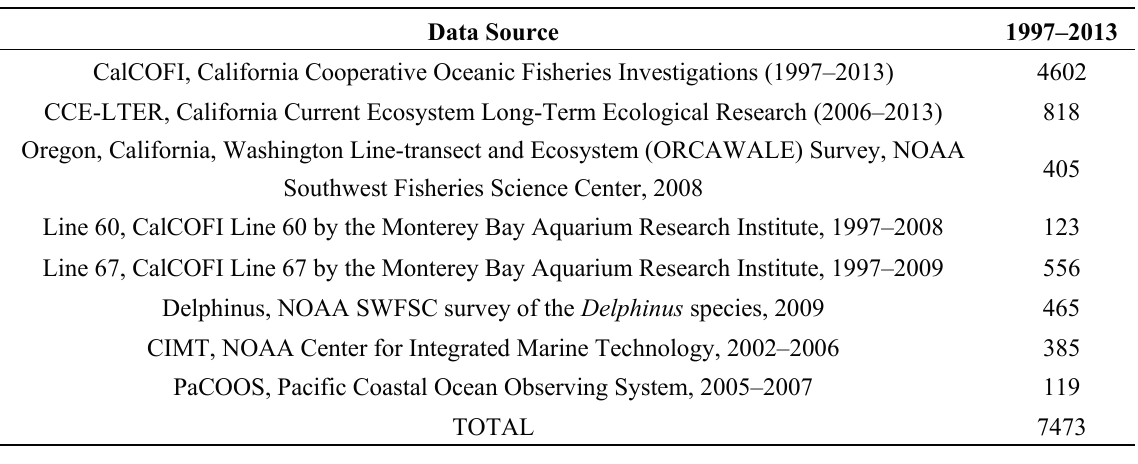
Table 1. Sources of in situ surface Chla data and the corresponding number of stations.